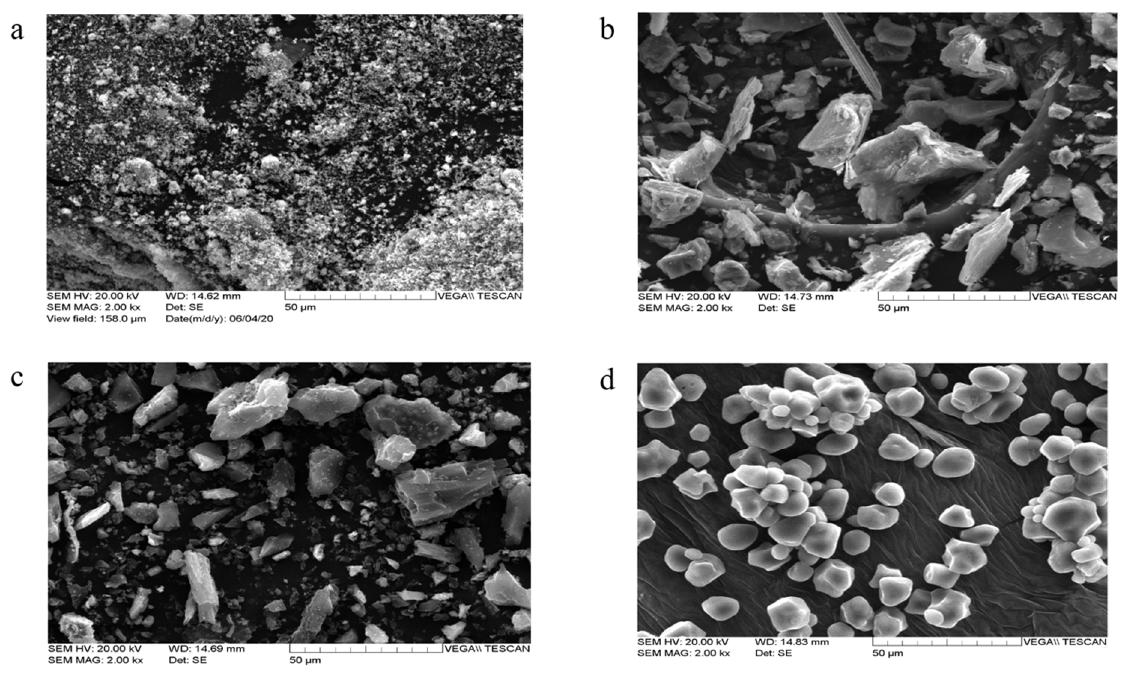
Figure 1. Scanning electron microscopy (SEM) images of ( a ) magnetite, ( b ) talc, ( c ) activated carbon, and ( d ) corn starch.